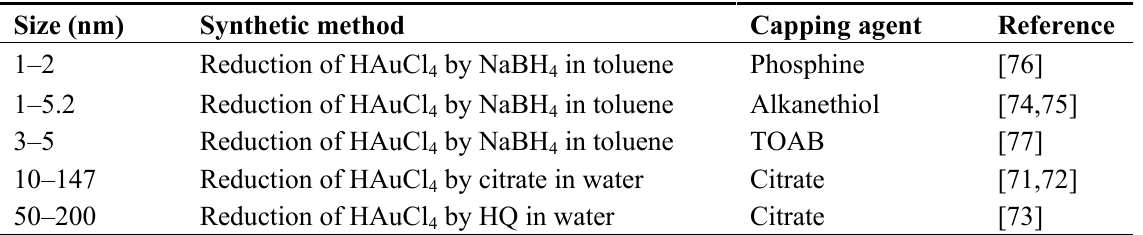
Table 4. List of synthesis methods of gold